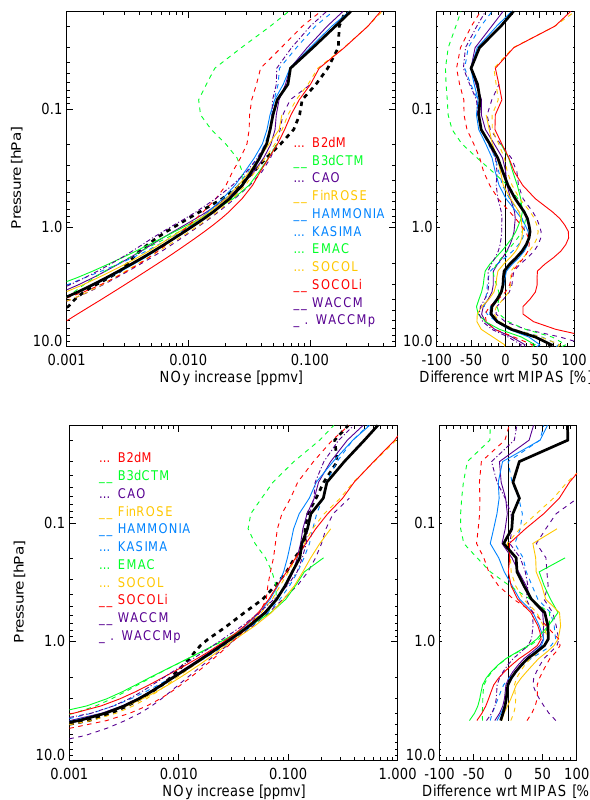
Fig. 12. Area-weighted averages of observed and modeled NO y enhancements for 40–90 ◦ N (top) and 70–90 ◦ N (bottom) during 30 October–1 November with respect to 26 October (left) and rela- tive deviations of modeled averages from the MIPAS observations (right). Thick solid and dashed lines represent the multi-model mean and MIPAS observations, respectively. WACCMp denotes the WACCM simulation including proton ionization only (excluded from the multi-model mean).